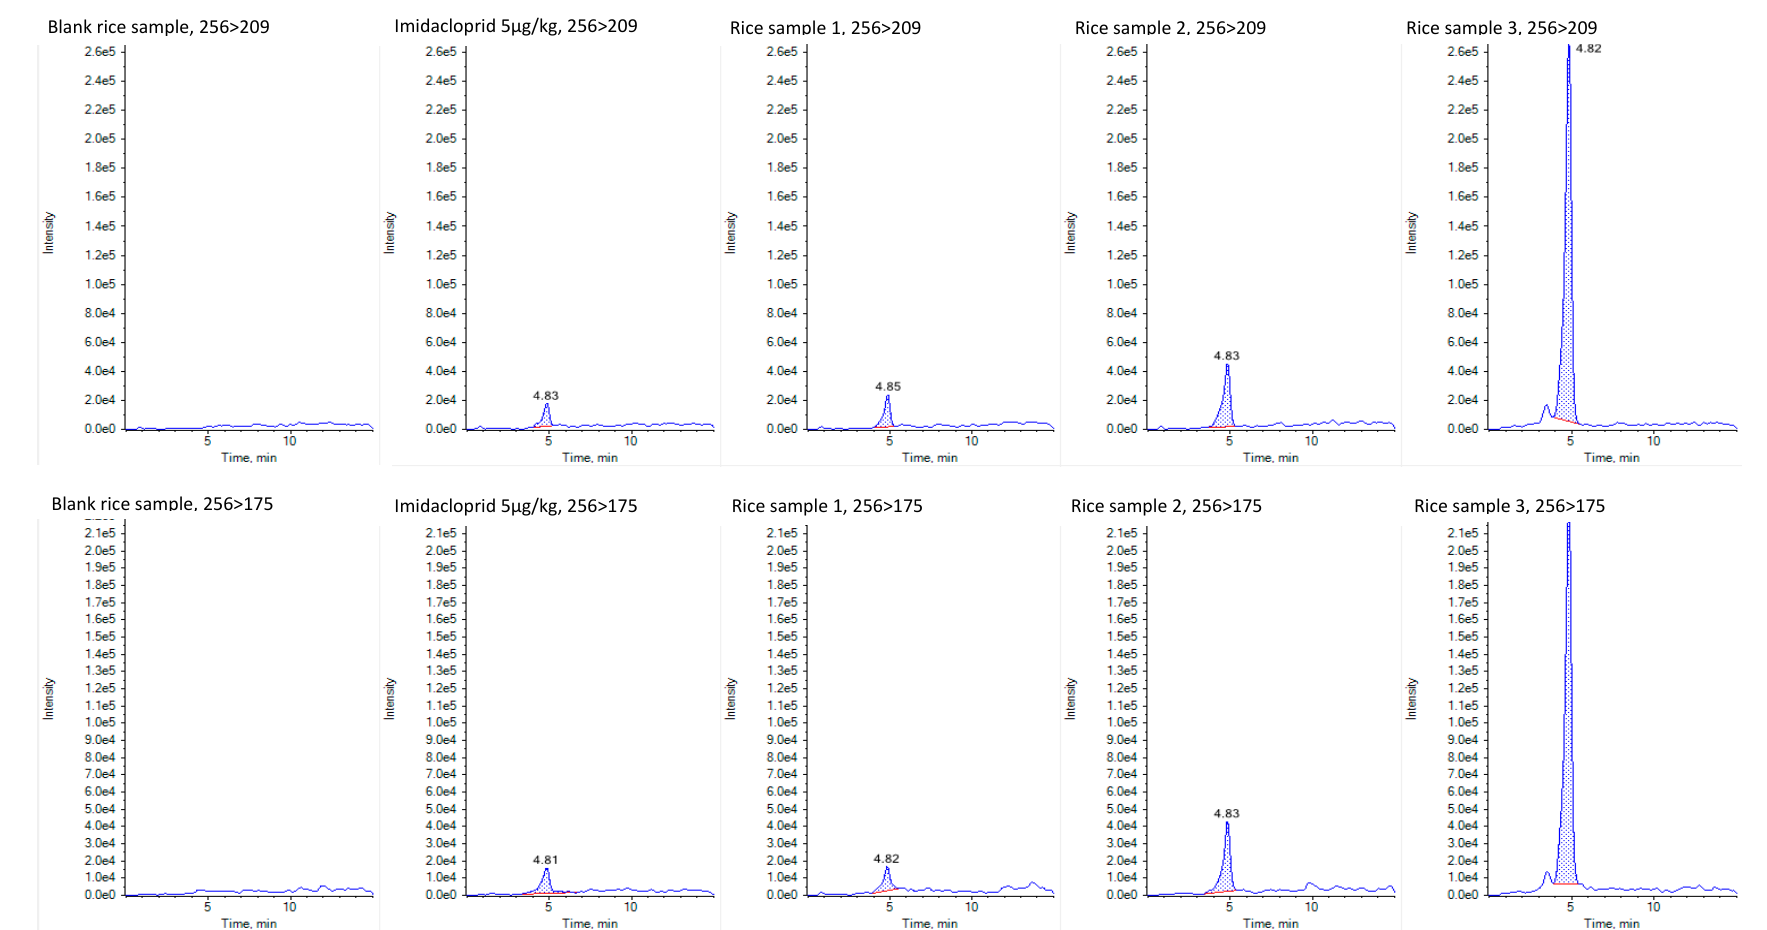
Figure 1. MS/MS chromatogram of a blank rice sample, imidacloprid standard (5 μ g/kg), rice sample 1, rice sample 2, and rice sample 3, showing both transitions Figure 1. MS / MS chromatogram of a blank rice sample, imidacloprid standard (5 µ g / kg), rice sample 1, rice sample 2, and rice sample 3, showing both transitions of of imidacloprid (256 > 209 and 256 > 175). imidacloprid (256 > 209 and 256 >